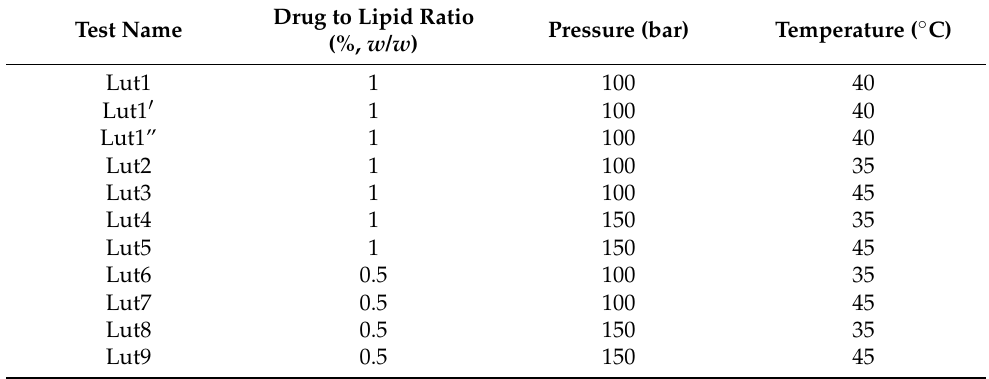
Table 1. Experimental conditions (pressure, temperature, drug to lipid ratio) used in this